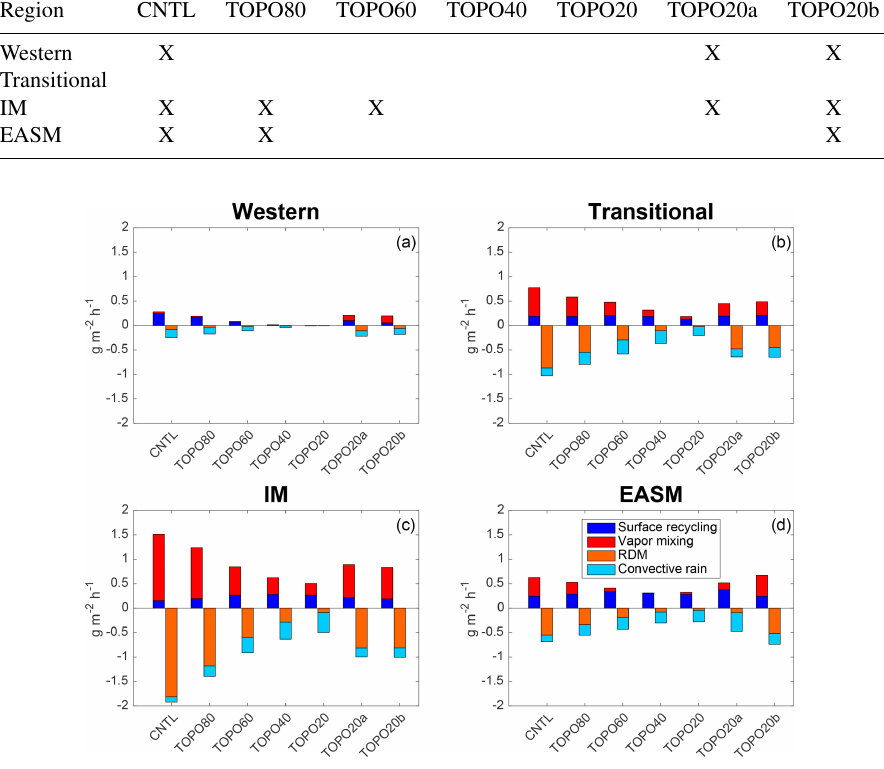
Figure 10. Summertime mass flux of 18 O (gm − 2 h − 1 ) for the (a) western Himalayas, (b) the transitional, (c) the IM, and (d) the EASM regions. Sources (positive values) and sinks (negative values) balance within 20% or 0.1gm − 2 h − 1 for fluxes that are close to zero. (Small errors in the net balance arise due to the centered-finite-difference method used to calculate derivatives in the advection terms.) Note that the largest source/sink varies by region and with elevation. Local convection and surface recycling are the dominant respective source and sink of 18 O in the western Himalayas and under low-elevation scenarios, while Rayleigh distillation and vapor mixing dominate in high-elevation scenarios in the monsoonal and transitional